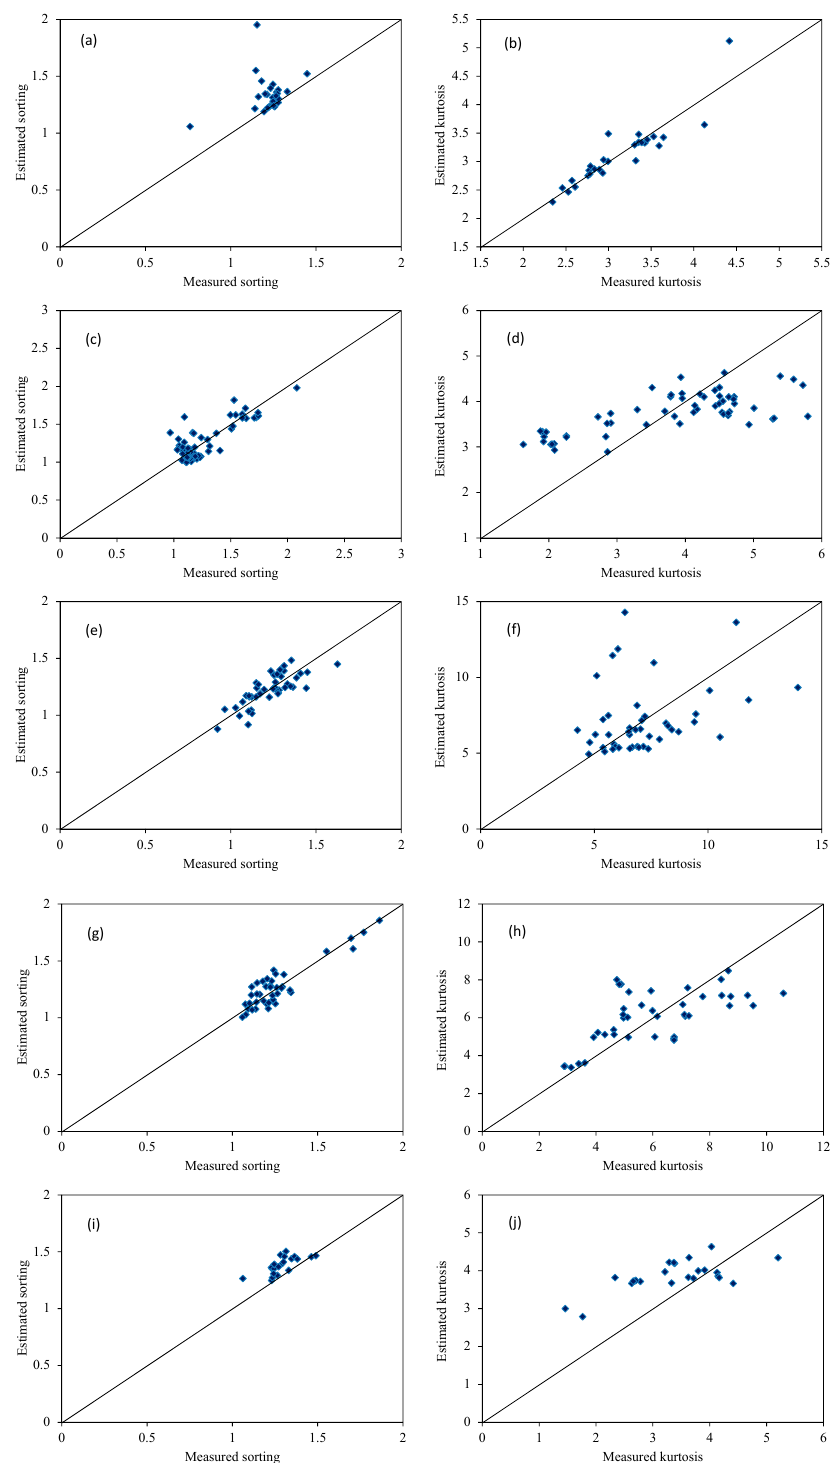
Figure 7. Comparison of the measured sorting and kurtosis values of the suspended particles with the estimated values from June 19–27, 2004 ( a , b ) and September 2012 ( c , d ) in the Yellow River estuary; in May ( e , f ) and September 2018 ( g , h ) in the Bohai Sea; and in the South Yellow Sea from March 19 to April 23, 2003 ( i , j ).